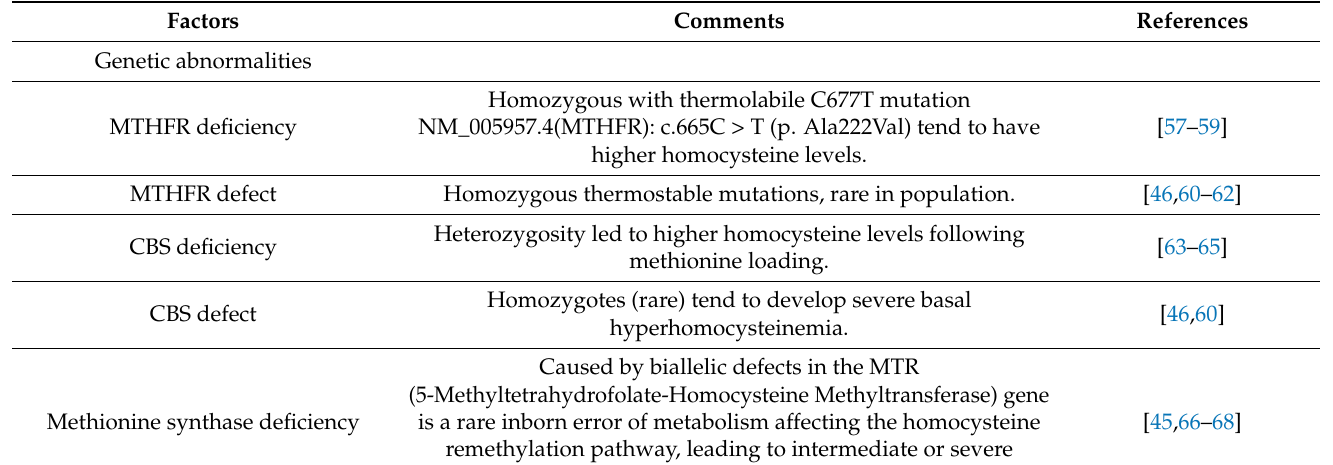
Table 1. Causes of elevated